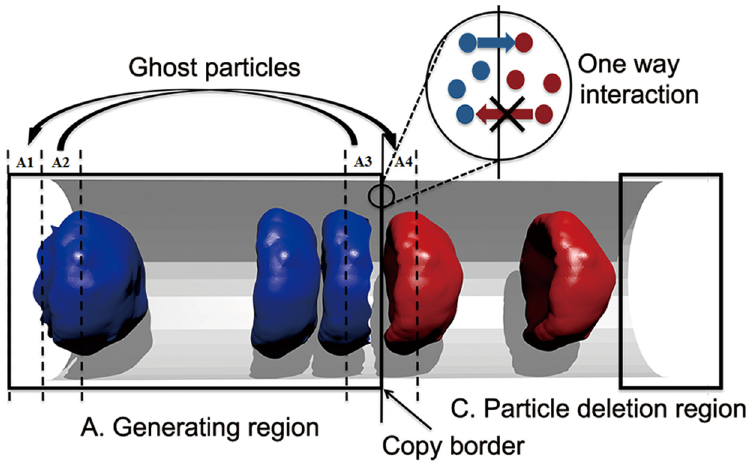
Fig 2. Schematic illustration of the computational domain of an open system. The generating region is divided into zones: zones A2 and A3 are sources of ghost particles while zones A1 and A4 are used for placing ghost particles. As soon as a particle crosses the copy border, its copy is created. There is one way interaction between particles in the generating region and particles in the main simulation domain.